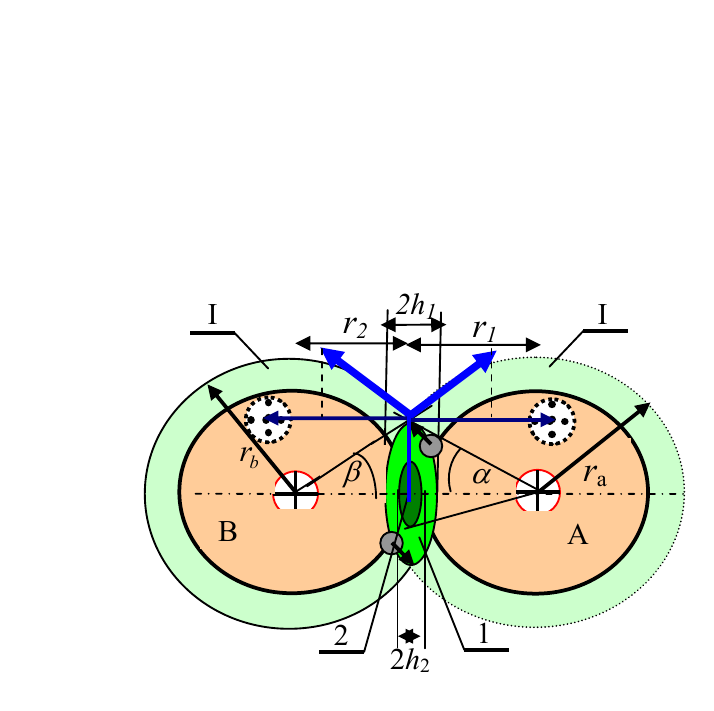
Figure 2 – Coulomb interaction of nuclei in the binary interaction of atoms Рис . 2 – Кулоновское взаимодействие ядер в бинарном